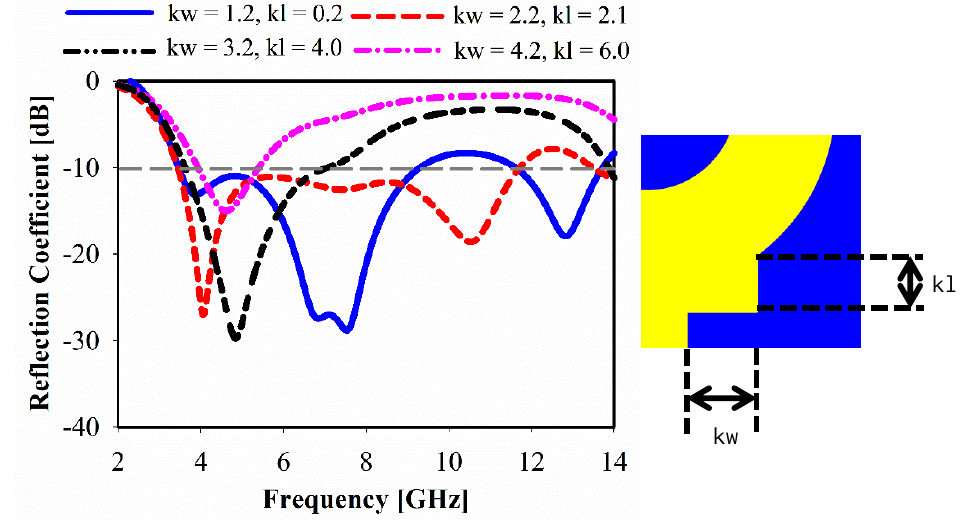
ffi cient for di ff erent width and length of key edge. Figure 11. Simulated reflection coefficient for different width and length of key edge. Figure 11. Simulated reflection coe